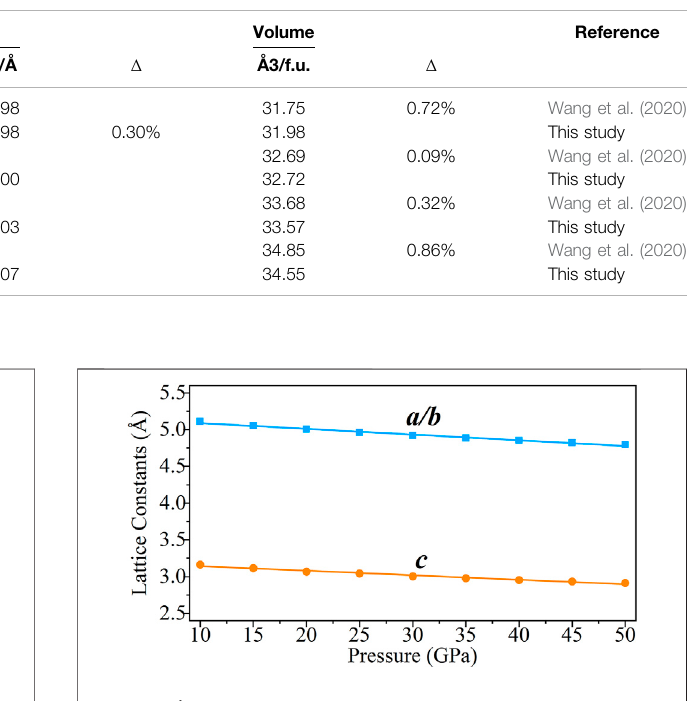
FIGURE 2 | Lattice constants of CaO 3 under 10 – 50 GPa. The blue squares represent the lattice constant of a and b , and the orange circles represent the lattice constant of